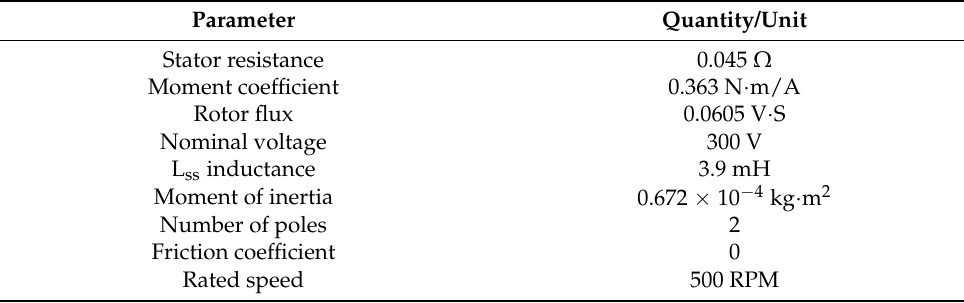
Table 1. The parameters of